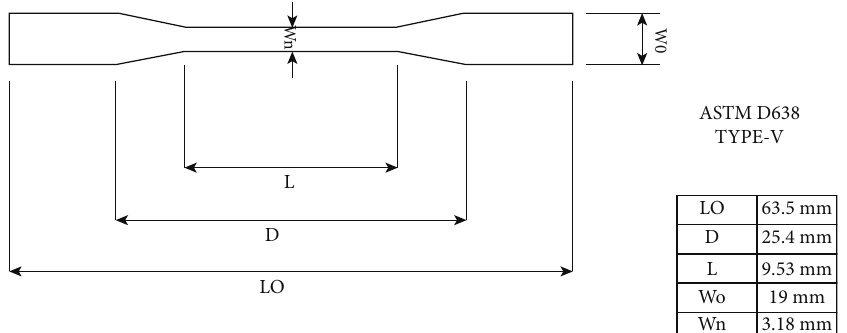
Figure 7: Geometrical standard of ASTM D638 type V [45].